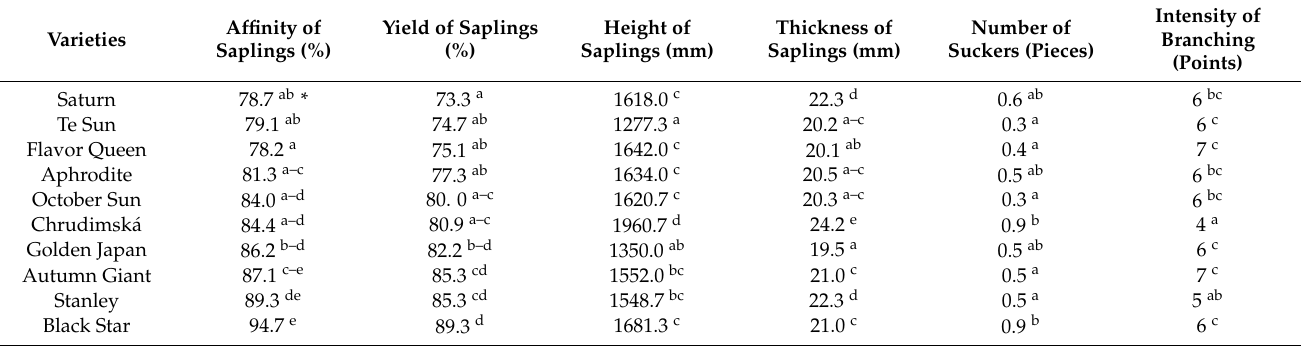
Table 3. Average trait values for variety and statistical significance (2019–2021).